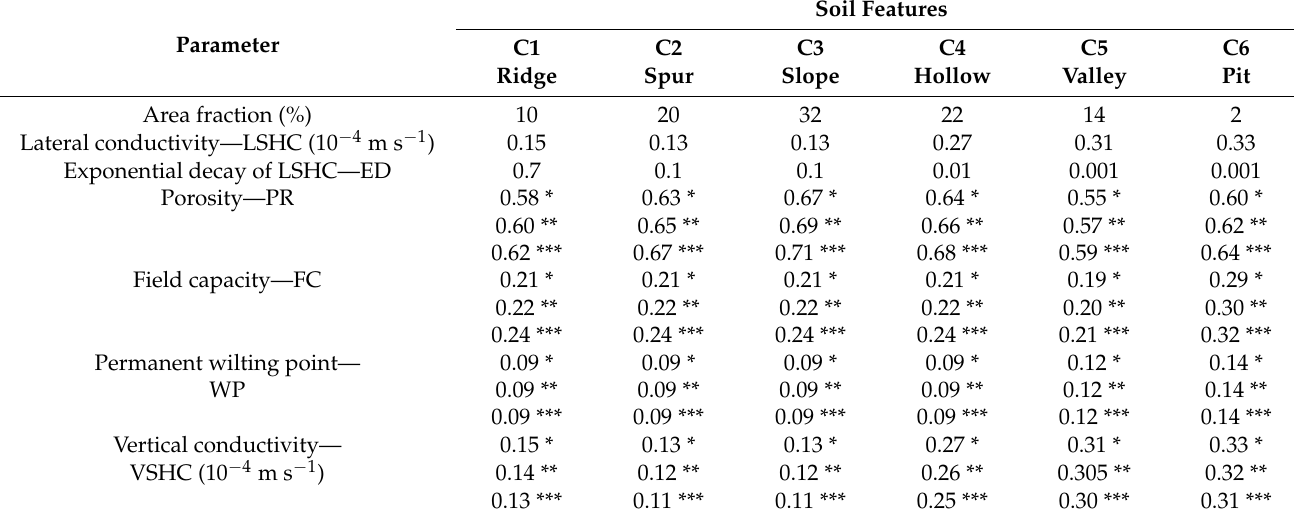
Table 3. Parameterization of the soil parameters in the DHSVM for the LCW using Geomorphons features.